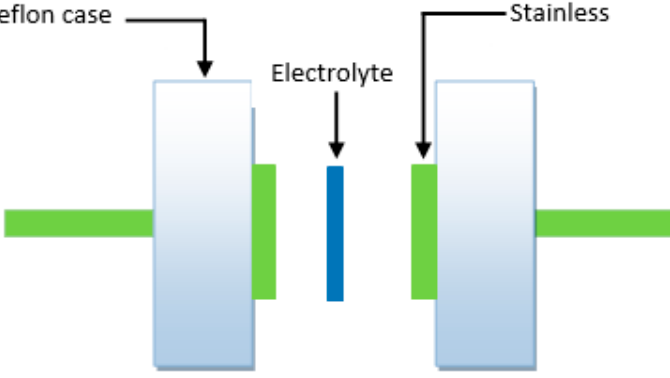
Figure 12. Schematic representation for recording TNM and LSV data.